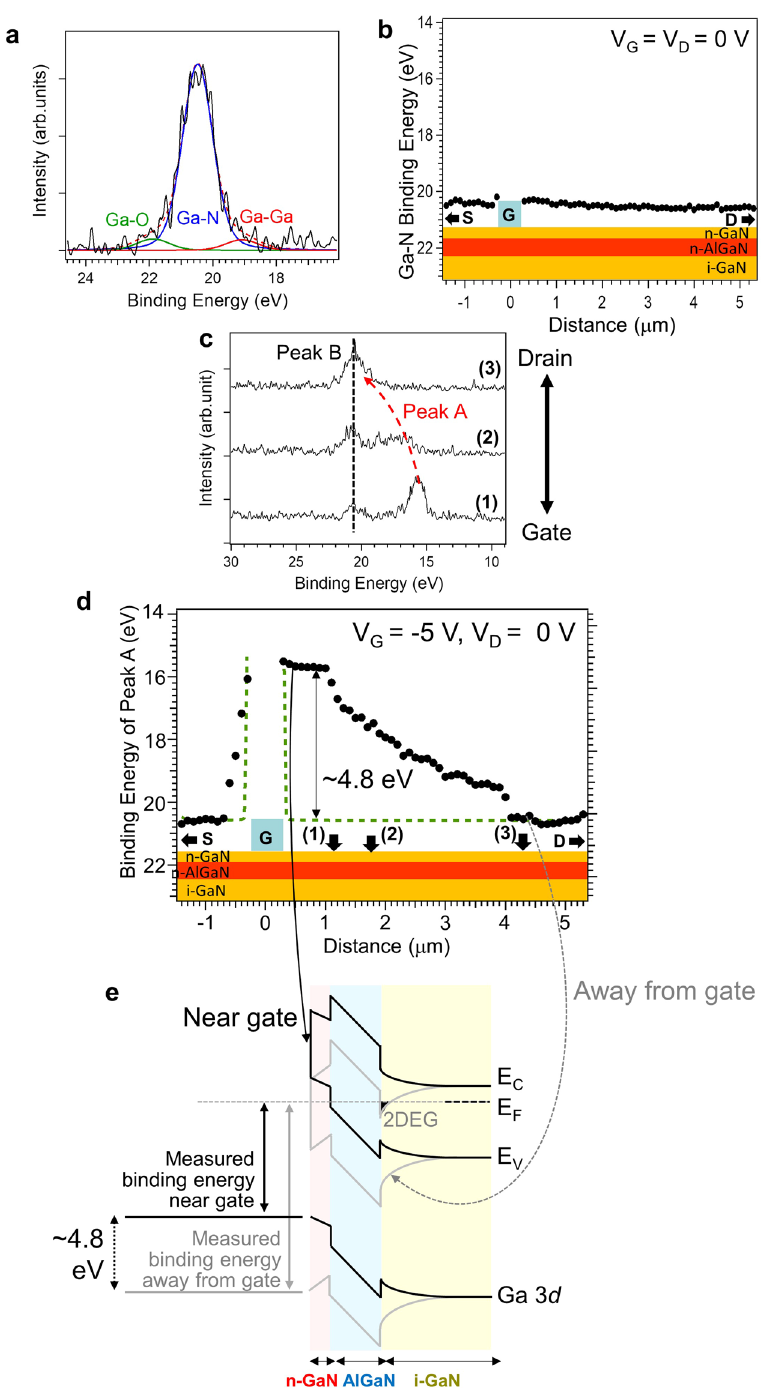
Figure 2. Operando photoelectron nanospectroscopy measurements of GaN-HEMT surface under gate bias application. ( a ) Typical Ga 3 d spectrum under zero bias application. ( b ) Line profile of the binding energy of the main Ga–N peak under zero bias application. ( c ) Spatially resolved Ga 3 d spectra under gate bias application. ( d ) Line profile of the binding energy of the main Ga–N peak under gate bias application. The green dotted line indicates the line profile in the absence of surface electron trapping. (e) Schematic band diagrams near the gate edge (black) and away from the gate edge